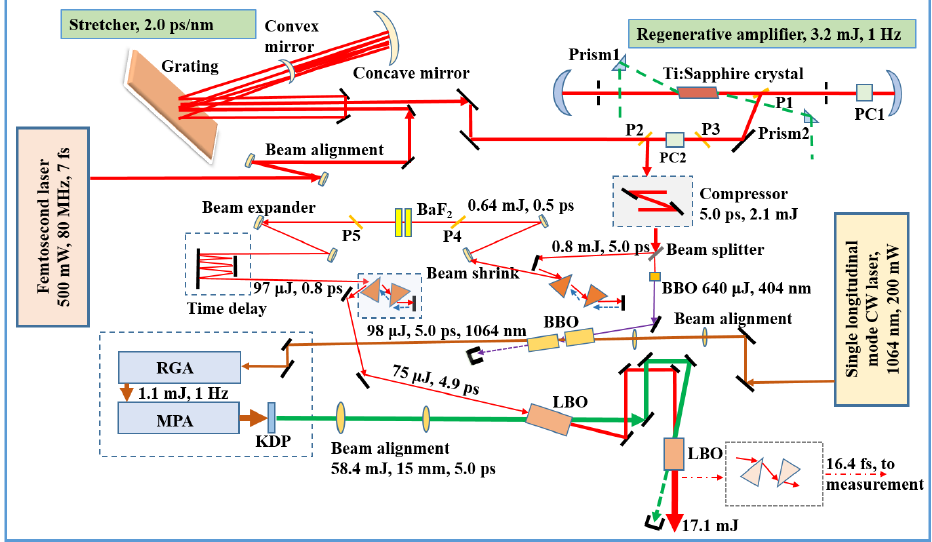
Figure 1. Schematic of optically synchronized frontend for petawatt-scale laser. P1 – P5, polarizers; PC1 – PC2, Pockels cells; RGA, regenerative amplifier; and MPA, master power amplifier.